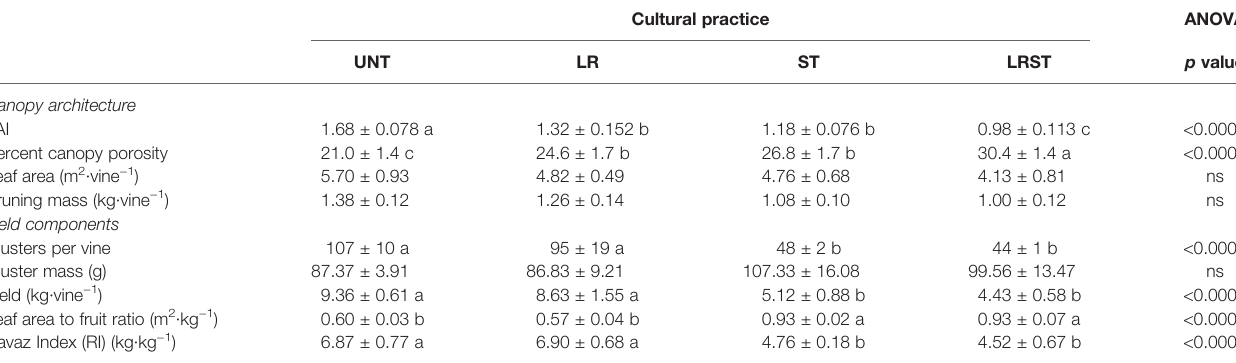
TABLE 3 | Effect of the canopy management practices untreated control (UNT), leaf removal (LR), shoot thinning (ST), and a combination of both (LRST) on the canopy architecture, and yield components of Cabernet sauvignon grown in Oakville, CA in